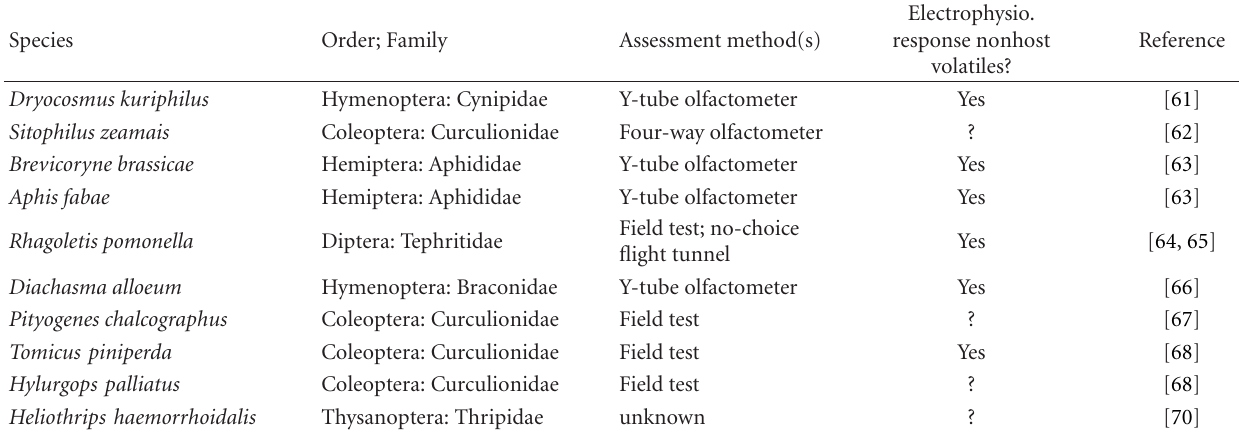
Table 3: Studies showing evidence consistent with insect avoidance of nonhost plants and/or their